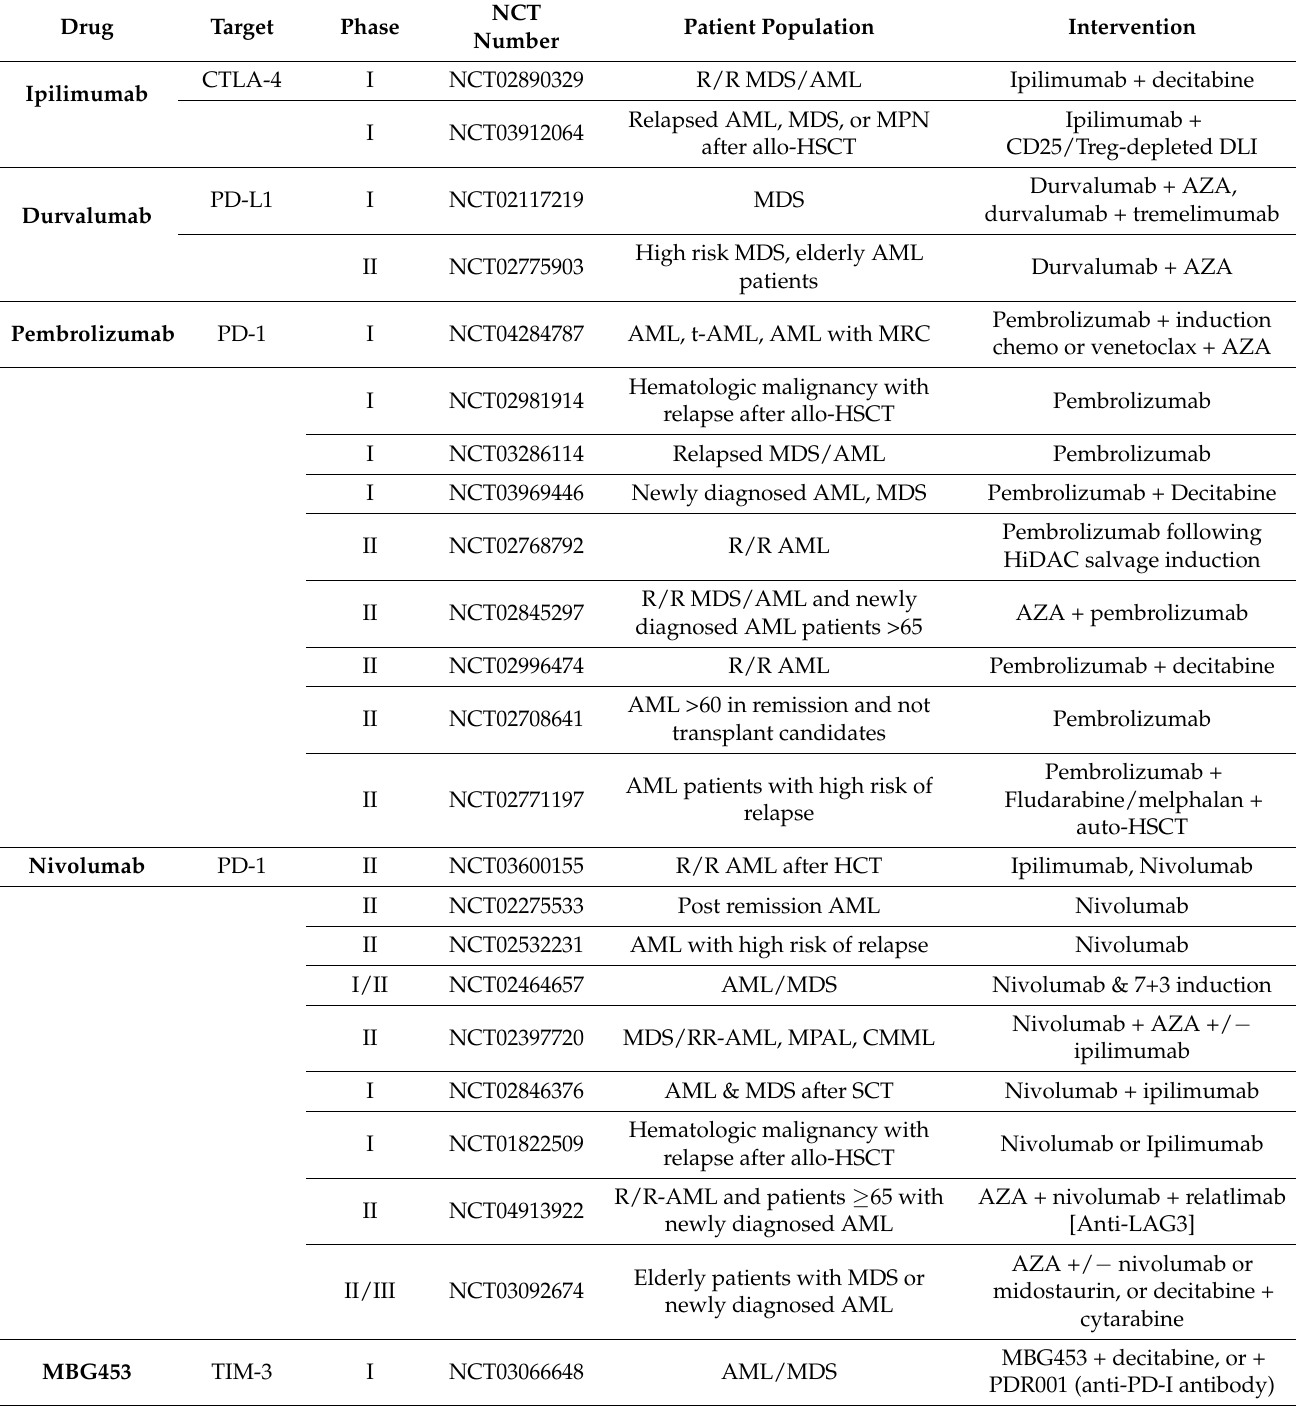
Table 3. Clinical trials using checkpoint inhibitors for the treatment of myeloid malignancies. T-AML, therapy-related AML. R/R. relapsed/refractory. DLI, donor lymphocyte infusion. MPAL, mixed phenotype acute leukemia. CMML, chronic myelomonocytic leukemia. AZA,